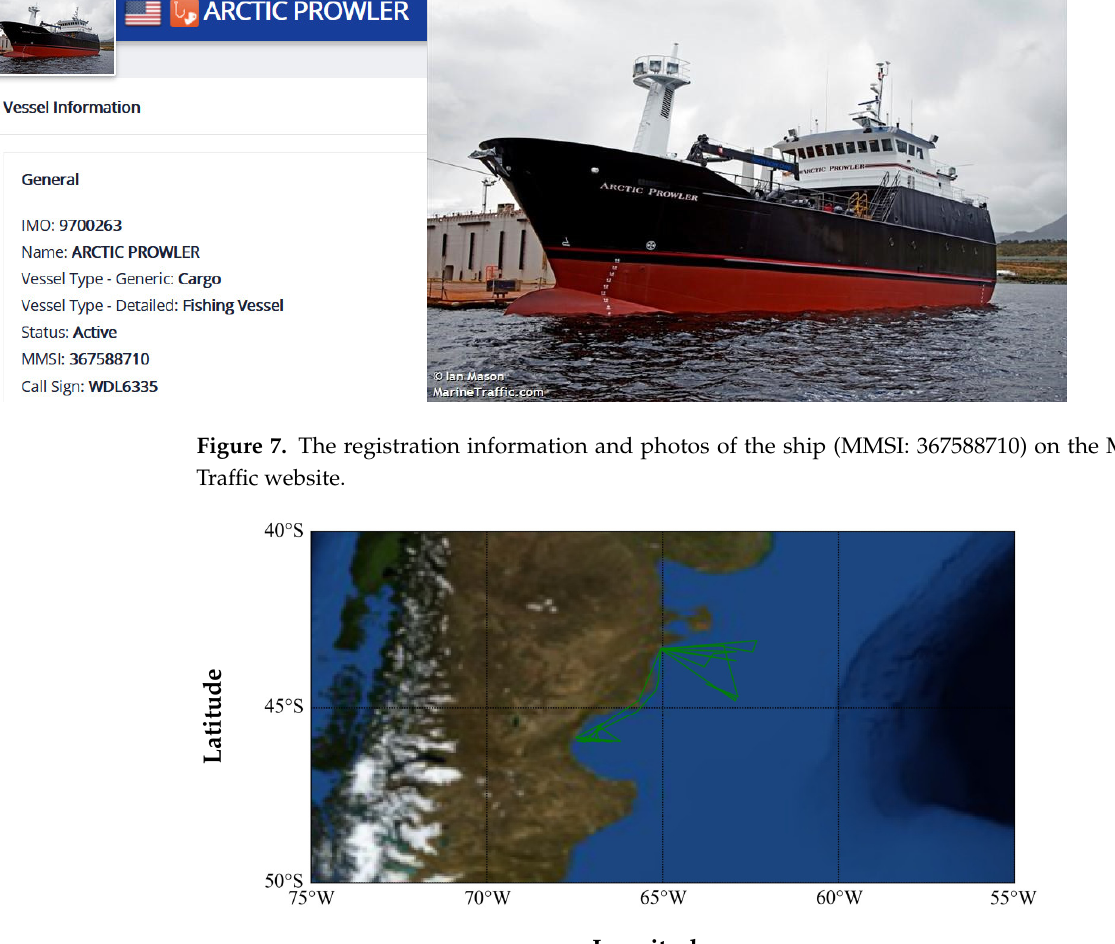
Figure 8. The historical trajectory of the ship (MMSI: 701006130).